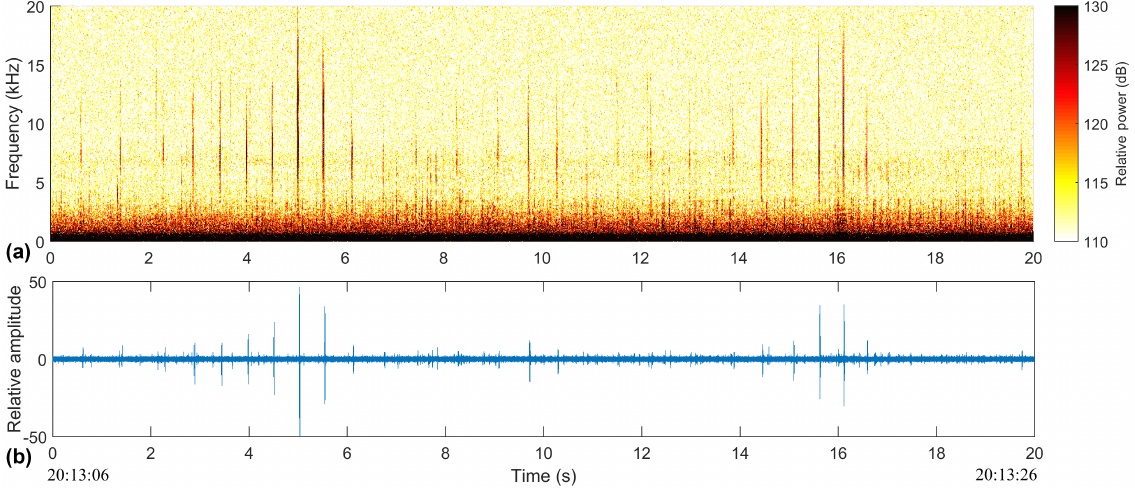
Figure 3. Spectrogram (a) and waveform (b) of 20s of data recorded on channel 1 of file 06 showing sperm whale regular clicks (narrow vertical bars). Time stamps are local time (CEST) on 9 June 2014. The relative amplitude corresponds to the amplitude in decibels minus the hydrophone sensitivity of − 161.4dB re